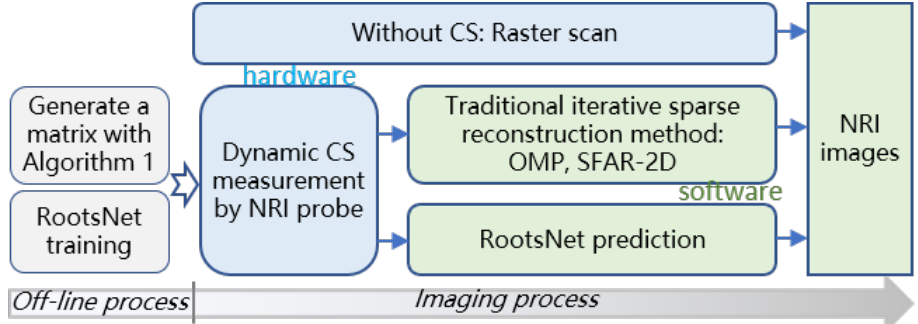
Figure 6. Implementation steps.